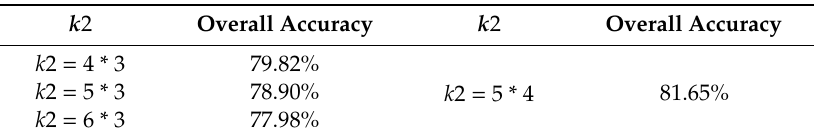
Table 7. The overall accuracy for the k 2 values in 2016, where k 2 refers to the division of the confusion bins that existed following the initial binning into k 2 bins. k